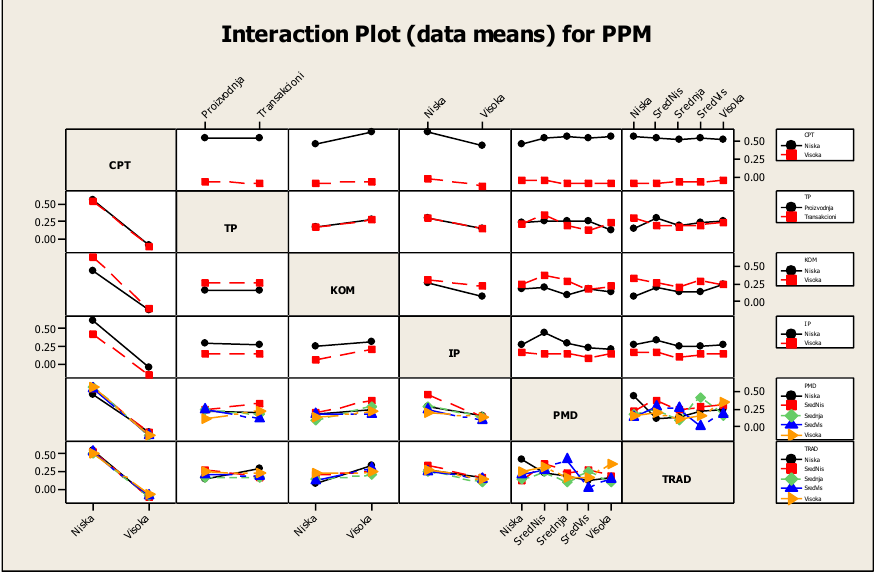
Fig. 12. Interaction plot